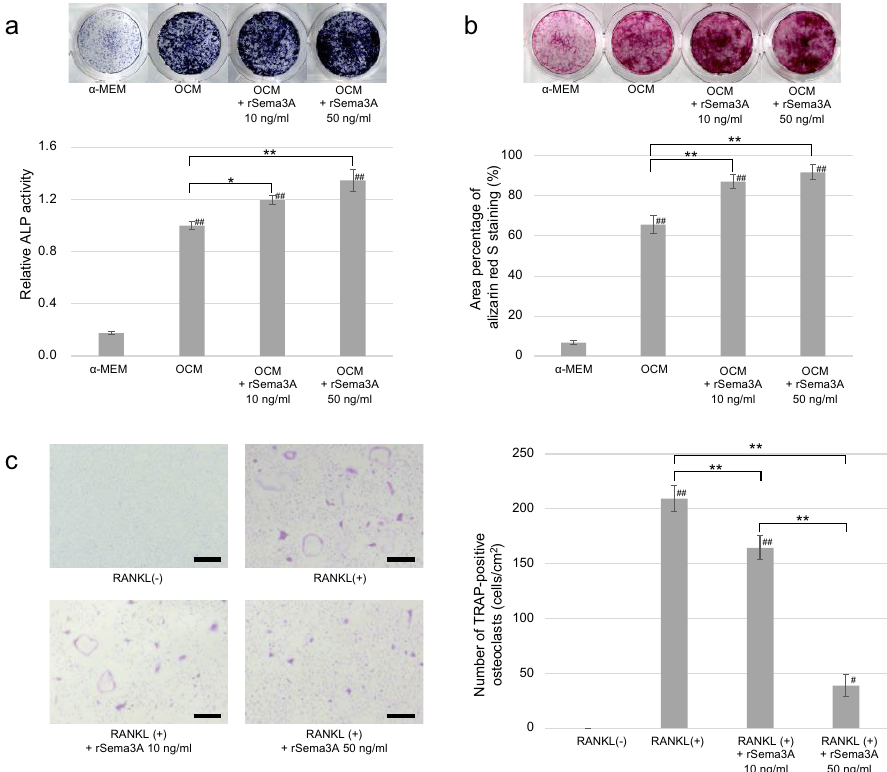
Figure 2. Osteoblasts were cultured in α-MEM and OCM with or without rSema3A (10, 50 ng/mL). ( a ) Alkaline phosphatase (ALP) staining and relative ALP activity (n = 3) at day 7. 10 ng/mL and 50 ng/mL rSema3A was significantly higher than that of the control cells. ( b ) Alizarin red S staining and area percentage of alizarin red S staining (n = 3) at day 21. 10 ng/mL and 50 ng/mL rSema3A significantly enhanced osteoblast extracellular calcification compared to control cells. * p < 0.05 and ** p < 0.01. # p < 0.05 and ## p < 0.01 vs. α-MEM ( c ) TRAP staining and number of TRAP-positive osteoclasts (n = 3). Bone marrow-derived monocyte/ macrophage precursor cells (BMMs) were cultured with or without rSema3A (10, 50 ng/mL). rSema3A significantly reduced osteoclast formation. * p < 0.05 and ** p < 0.01. # p < 0.05, ## p < 0.01 vs. RANKL (-). Scale bars = 500 µm. Data are presented as mean ±